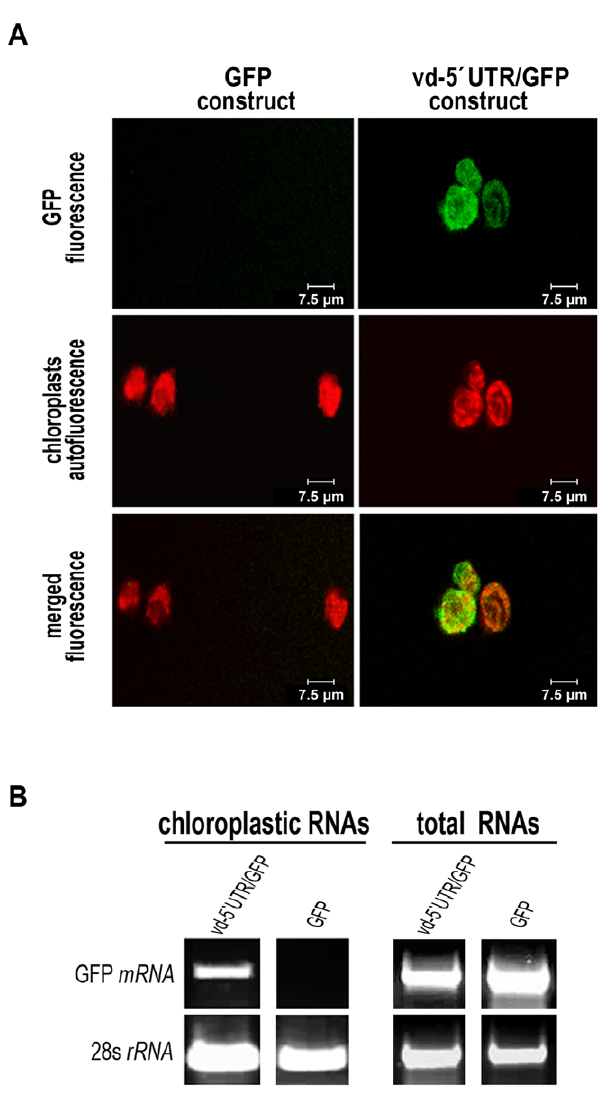
Figure 4. Vd-5 9 UTR mediates the traffic of functional GFP- mRNA to chloroplasts. ( A ) Confocal microscope observation of chloroplasts isolated from leaves expressing GFP or vd-5 9 UTR/GFP. ( B ) RT-PCR analysis of GFP transcripts extracted from chloroplasts isolated from leaves infiltrated with both constructs. Chloroplast ribosomal RNA 28 s was amplified as a control of isolated-chloroplasts